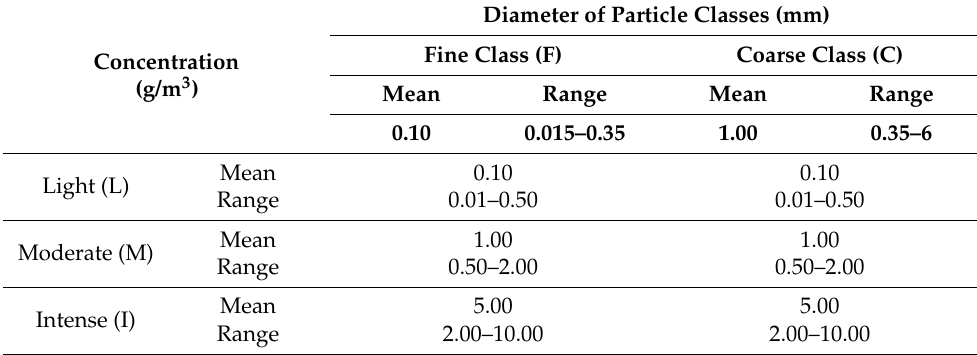
Table A2. Statistical properties of synthetic tephra (modified from